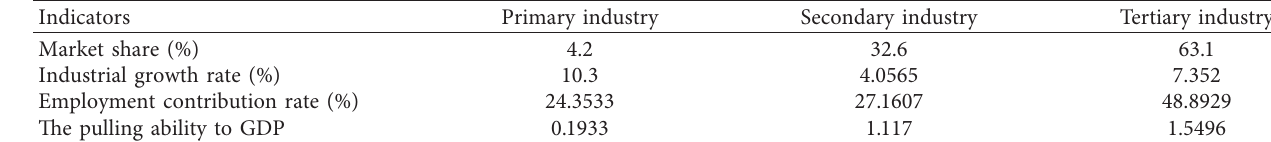
Table 8: Summary of indicators of three major industries.